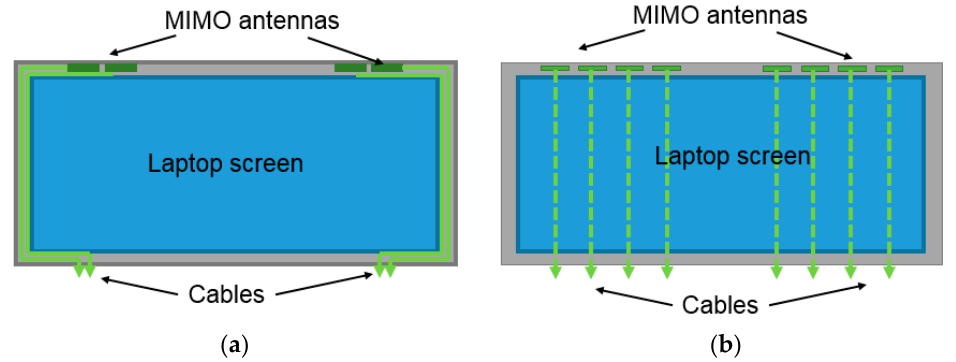
Figure 1. Connection cables placement scenarios on a laptop. ( a ) Cables passing through the bezel. ( b ) Cables under the screen. Scenario ( b ) can have more and shorter cables than scenario ( a ).